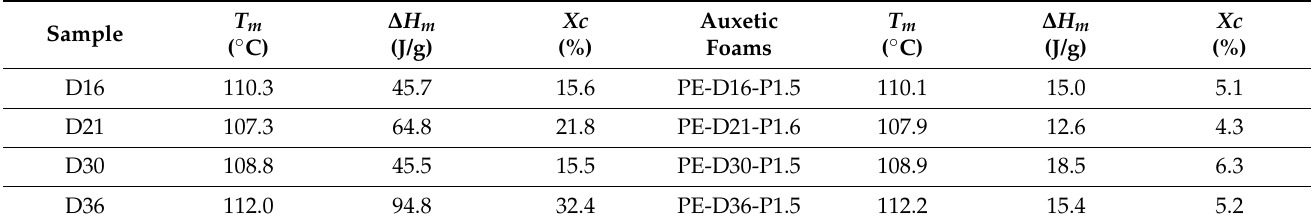
Table 2. DSC results (main peak) of the initial LDPE and auxetic foams.